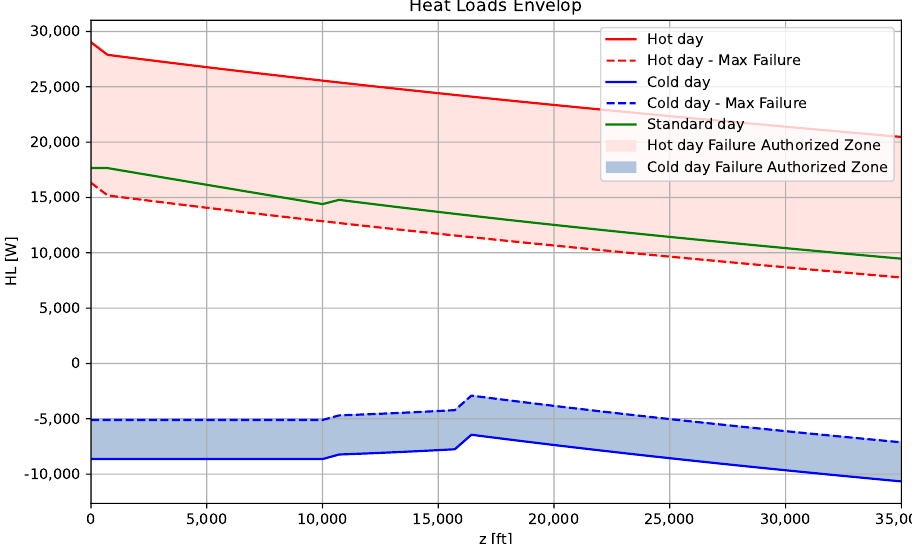
Figure 2. Heat loads envelope for an Airbus A320-type